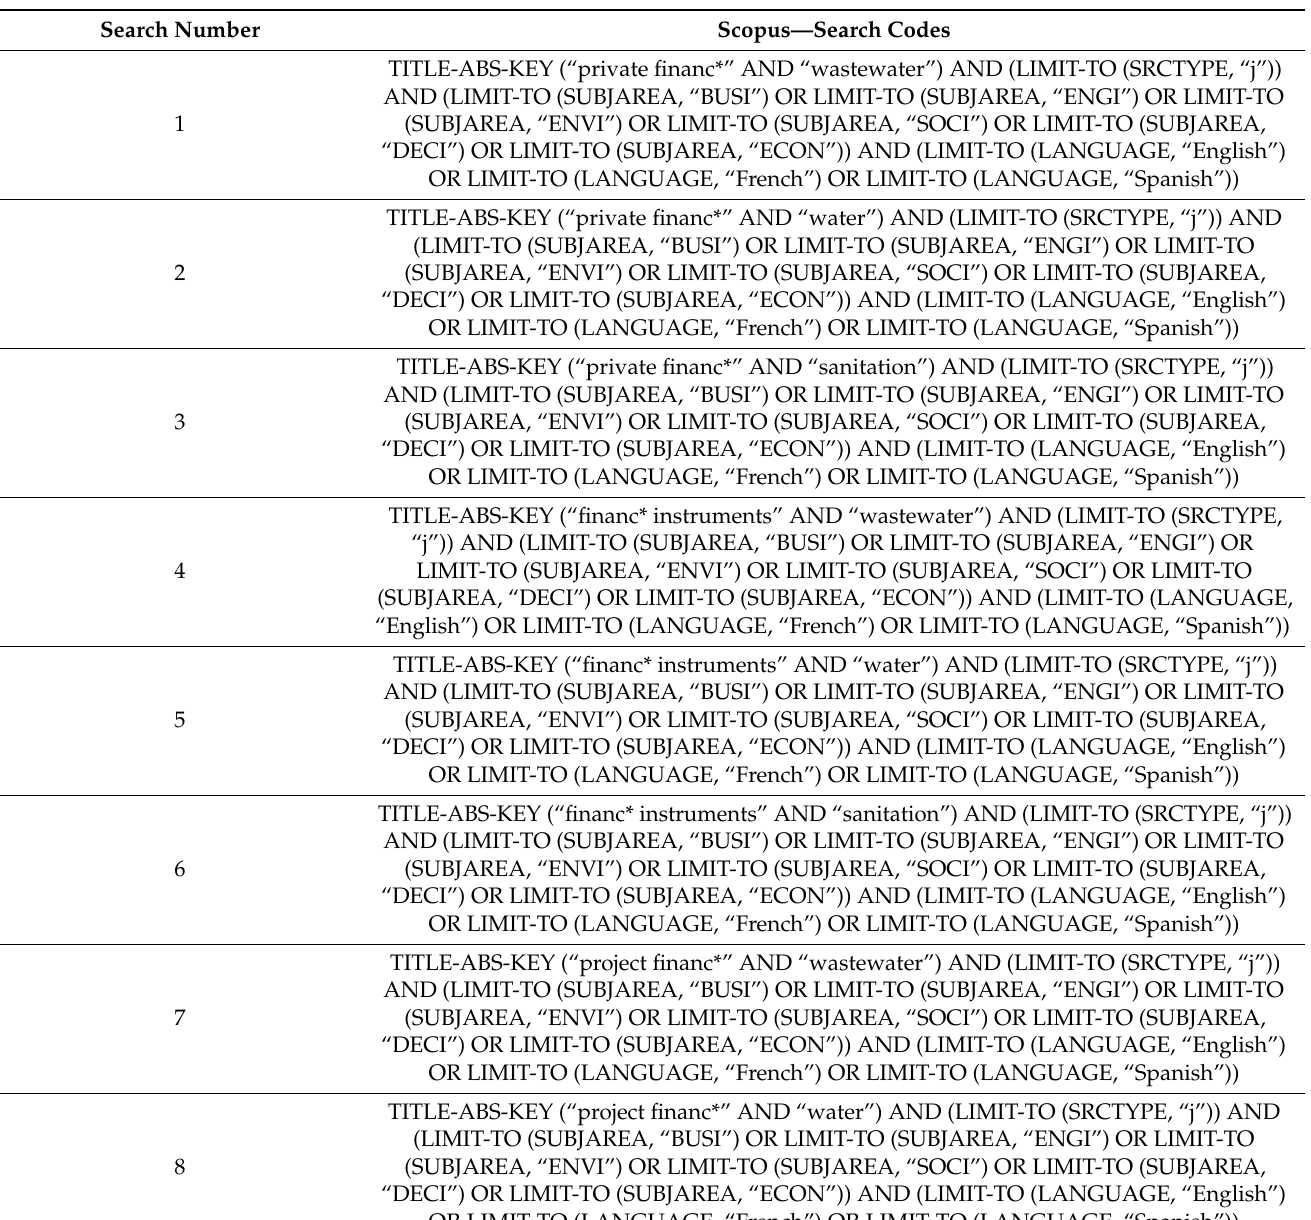
Table A1. Scopus search